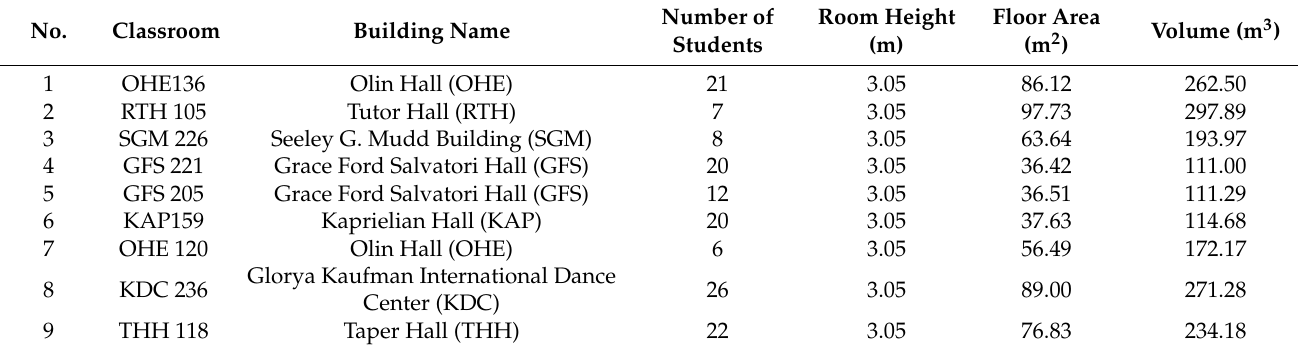
Table 1. Characteristics of the investigated